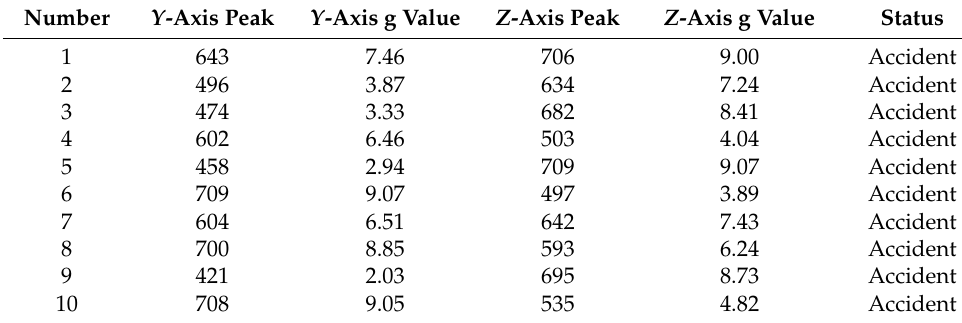
Figure 9. ( a ) Graph of accident test, peak value = 738; ( b ) g value. Table 4. The results of the Y and Z -axis when an accident